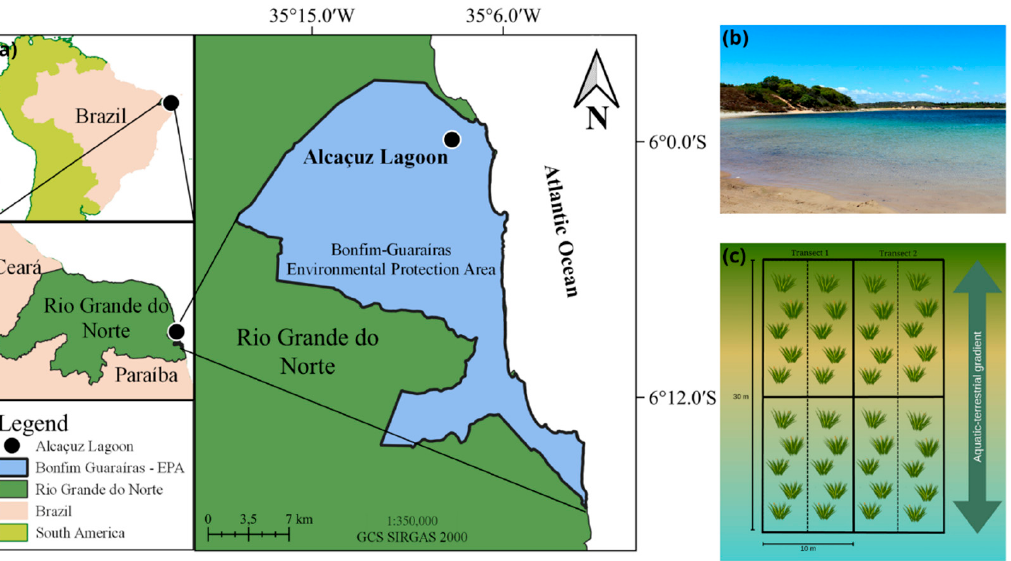
Figure 1. A location map of the Alcaçuz Lagoon, in the Bonfim-Guaraíras Environmental Protection area, Rio Grande do Norte State, Brazil ( a ), and draw of the methodology adopted to collect sediment and soil samples ( b , c ).